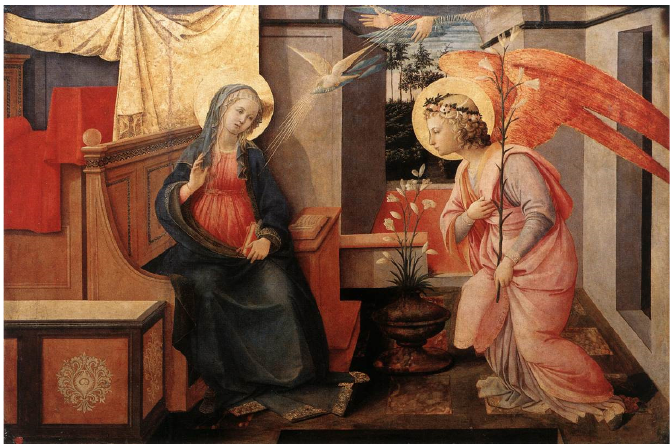
Figure 7. Fra Filippo Lippi, The Annunciation ( L’Annunciazione Doria ), c. 1445–50, Galleria Doria- Pamphilj, Rome.